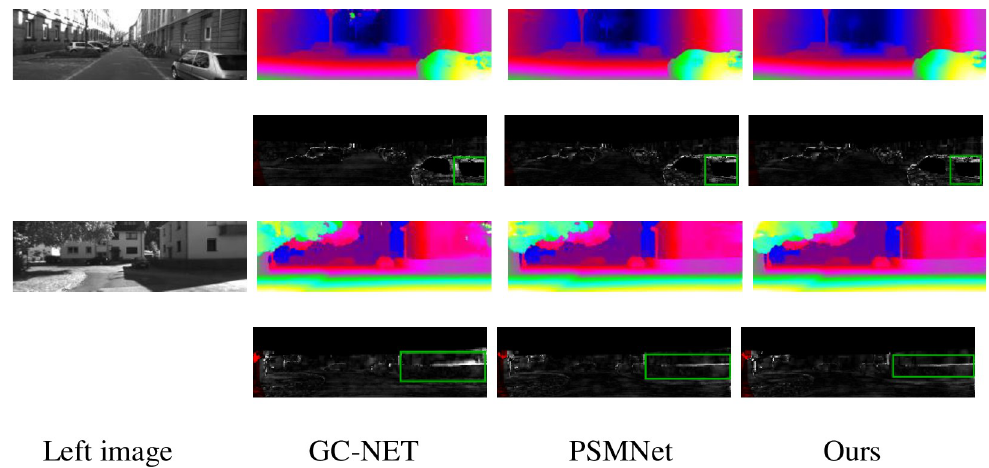
Fig 5. Qualitative evaluation results on the KITTI 2012 dataset. The first column shows the left images. For each photo, the first row shows the pseudocolor images for predicting the disparity map, and the second row shows the error maps. From left to right are the results of GC-NET [18], PSMNet [13], and our method,